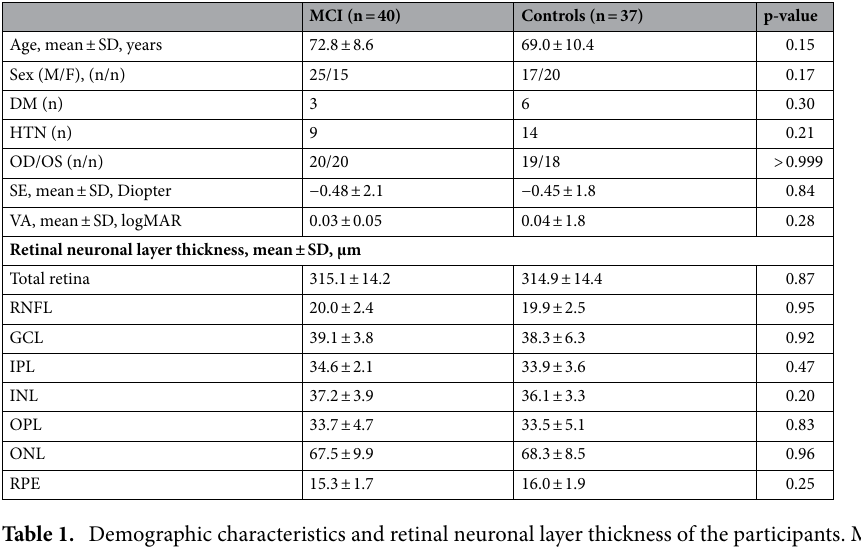
Table 1. Demographic characteristics and retinal neuronal layer thickness of the participants. MCI = mild cognitive impairment, M = male, F = female, DM = diabetes mellitus, HTN = hypertension, SE = spherical equivalent, OD = right eye, OS = left eye, VA = visual acuity, logMAR = logarithm of the minimum angle of resolution, RNFL = retinal nerve fiber layer, GCL = ganglion cell layer, IPL = inner plexiform layer, INL = inner nuclear layer, OPL = outer plexiform layer, ONL = outer nuclear layer, RPE = retinal pigment epithelium, SD = standard deviation. *p <